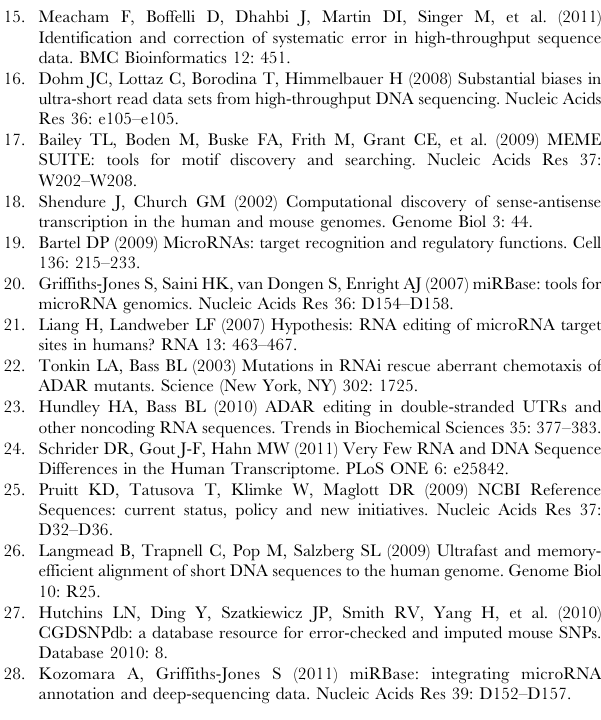
Figure S7 Effect of technical sequencing variation on gene expression and RNA editing. A) Effect sizes determined from fitting an ANOVA model to gene expression levels (measured as RPKMs) with respect to technical replicate (labeled ‘‘run’’) and tissue analyzed (model: RPKM , run*tissue). B) Effect sizes based on ANOVA analysis of edit ratios similarly to A (model: EditRatio , run*tissue). In both cases, the effect size of run is negligible. Table S1 Summary of reads and RNA editing sites identified from each tissue. Table S2 Homologues of RNA editing sites previously validated in human studies present in our samples. Table S3 All high confidence canonical editing